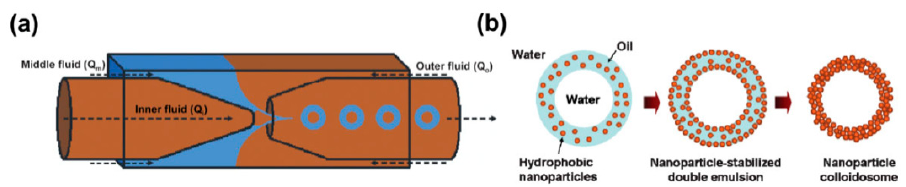
Figure 8. ( a ) Fabrication of PDE via microcapillary device. ( b ) Formation of nanoparticle colloidosomes from W/O/W PDE. Reprinted with permission from [18].